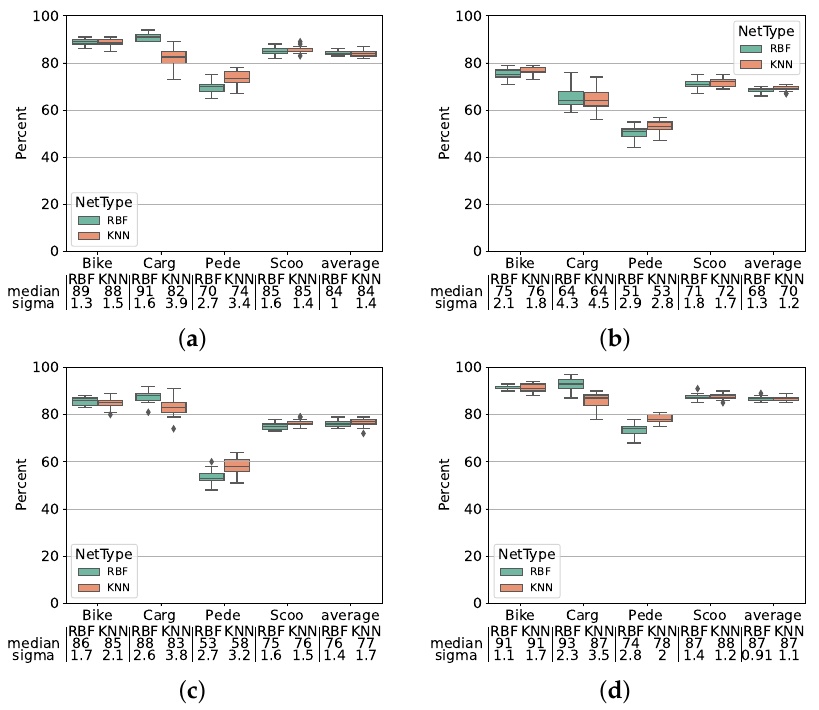
Figure 10. Best results for the tested feature extraction methods: ( a ) scaled ROI, ( b ) contour features, ( c ) contour moments, and ( d ) combined moments and scaled ROI.